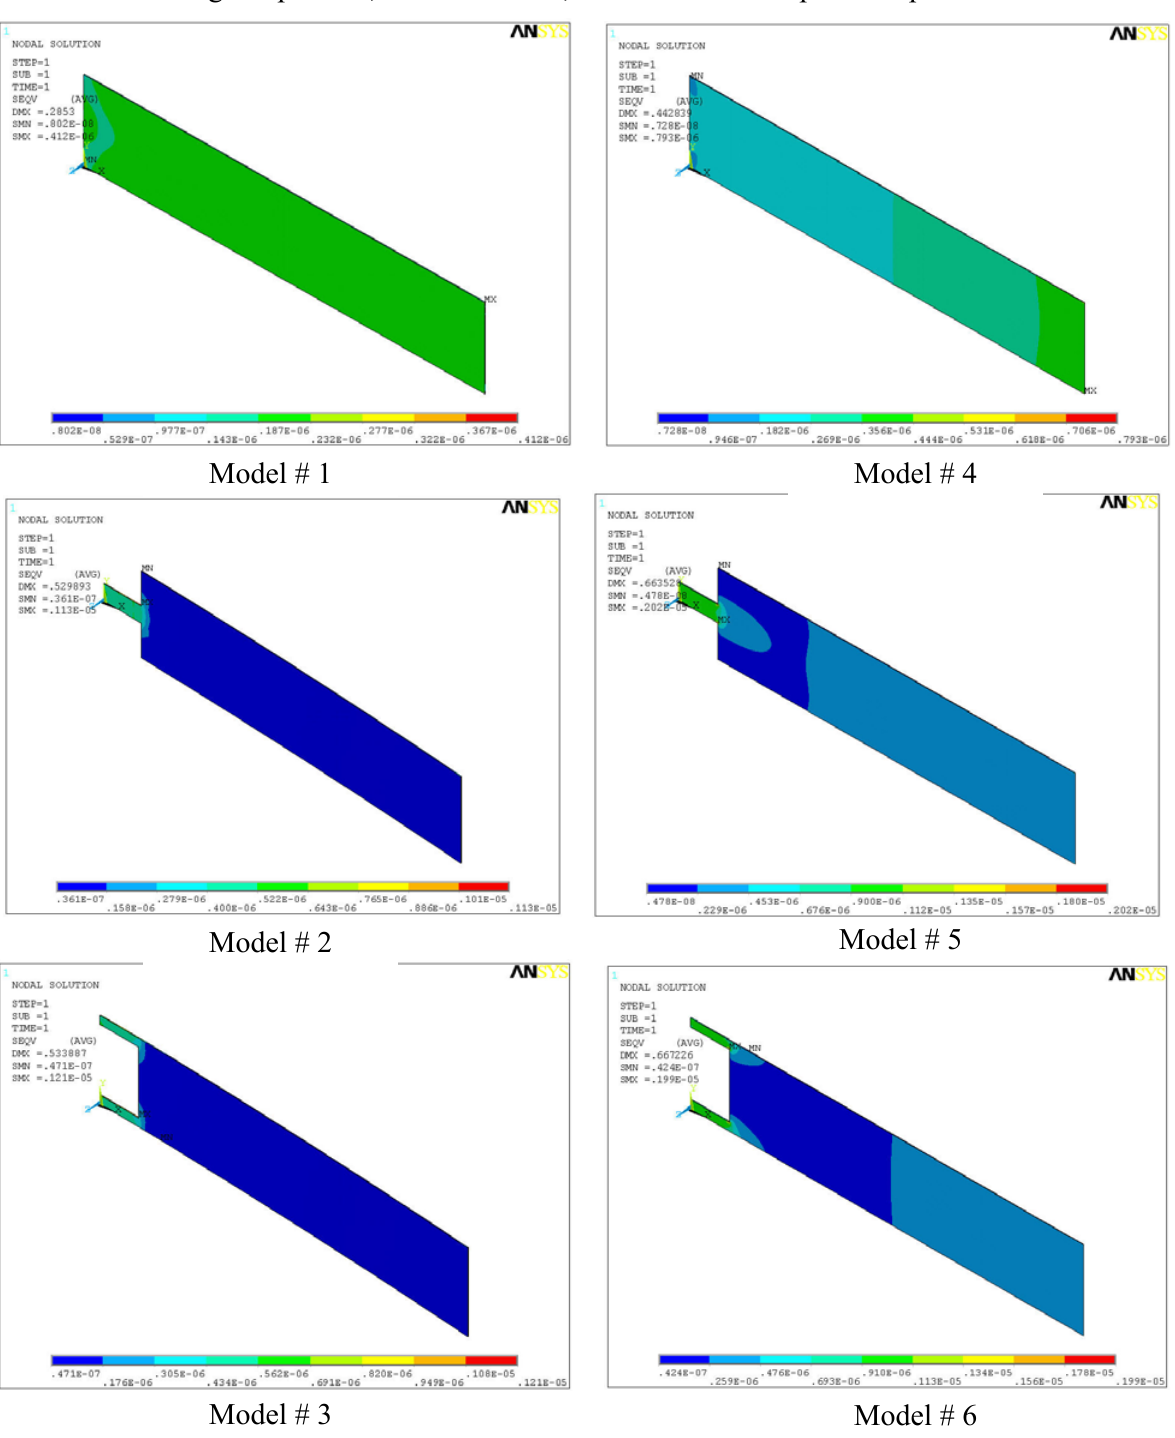
Figure 3. Von Mises stress distribution in the microcantilever models. Models #1, #2 and #3 have rectangular profiles, and Models #4, #5 and #6 have trapezoidal profiles.